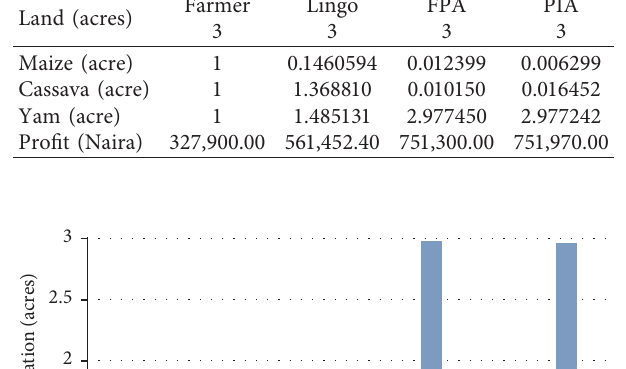
Table 2: Dominion farm, Ife, Osun State, Nigeria (cost of planting cassava per acre).